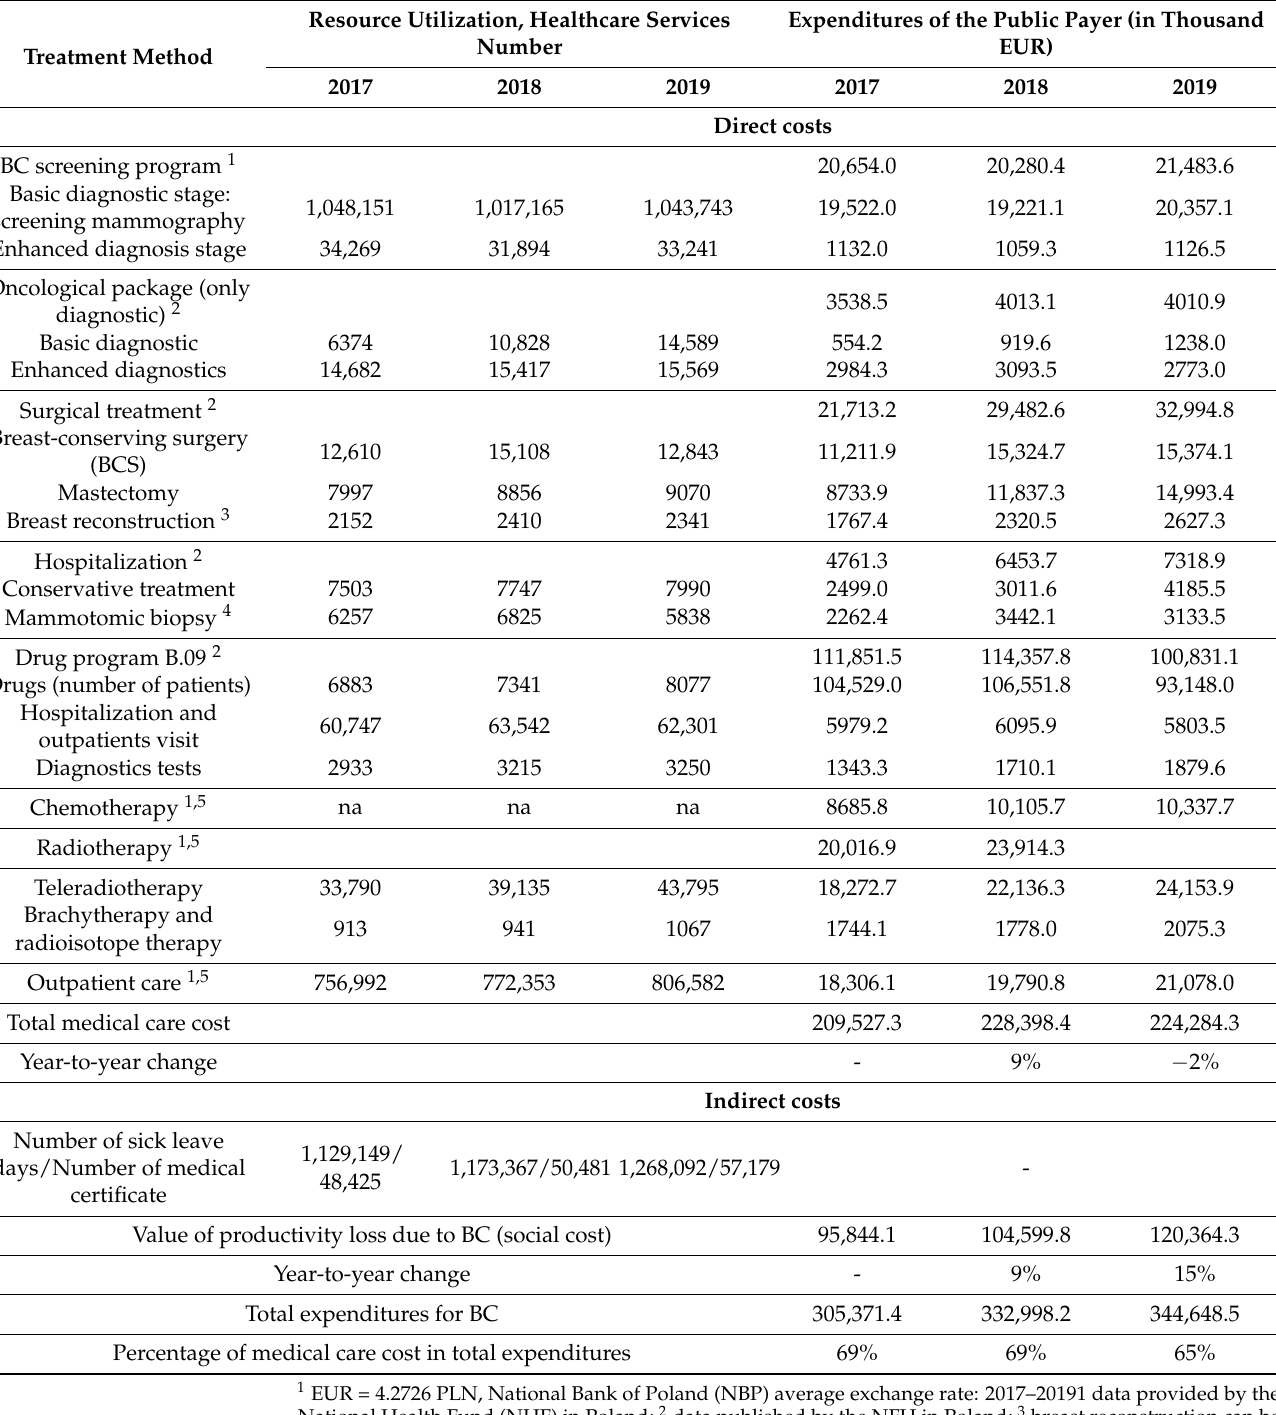
Table 1. The cost statement for breast cancer in